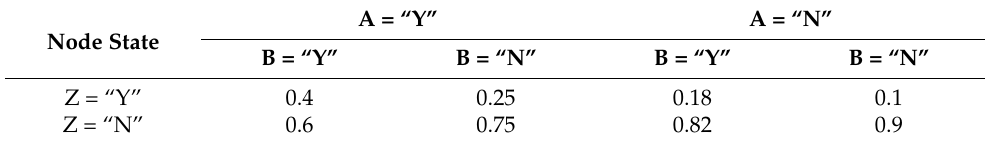
Table 6. Conditional probability of node Z